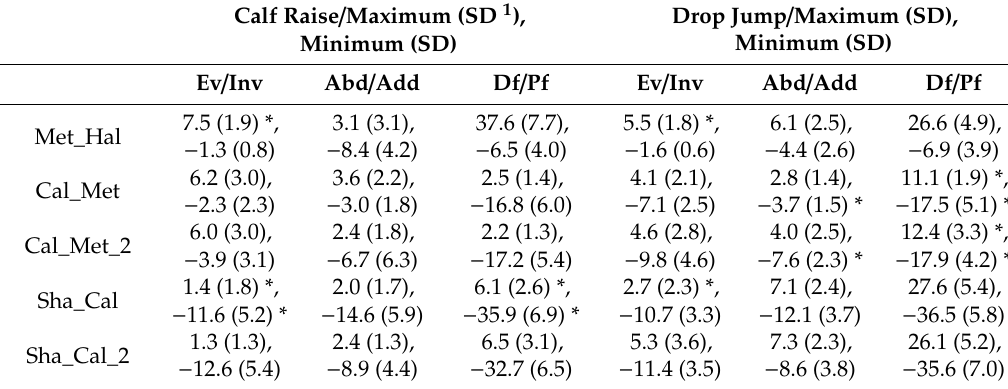
Table 4. Peak angle calculated according to our new model. (Unit: